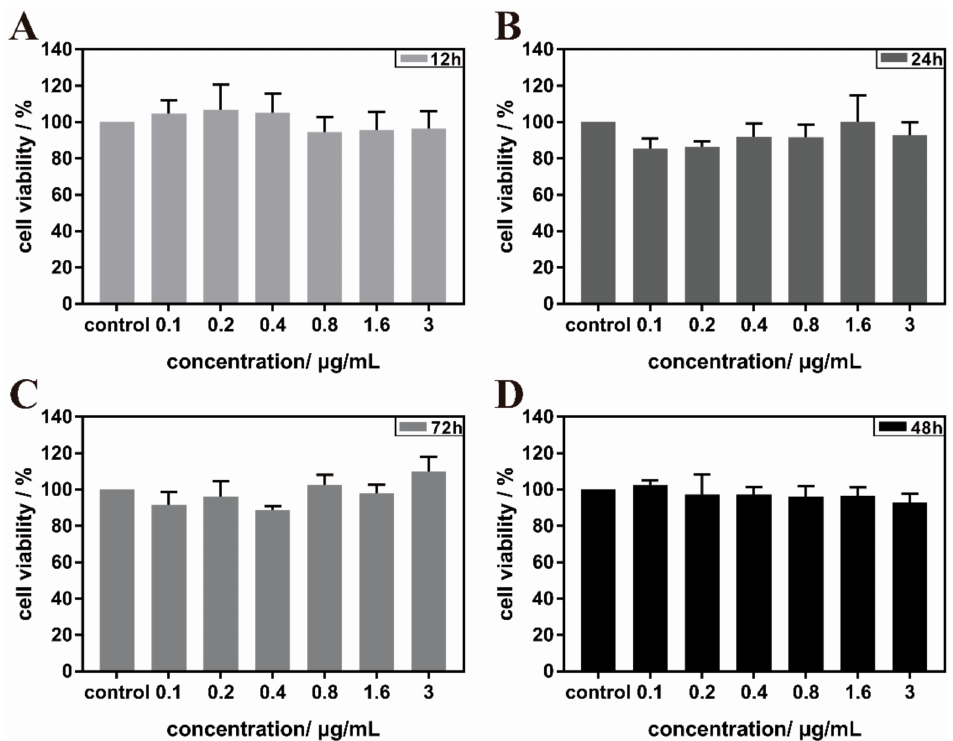
Figure 9. Survival rate of MIL-101(Fe)-T705-treated MDCK cells after 12 h ( A ), 24 h ( B ), 48 h ( D ), and 72 h ( C